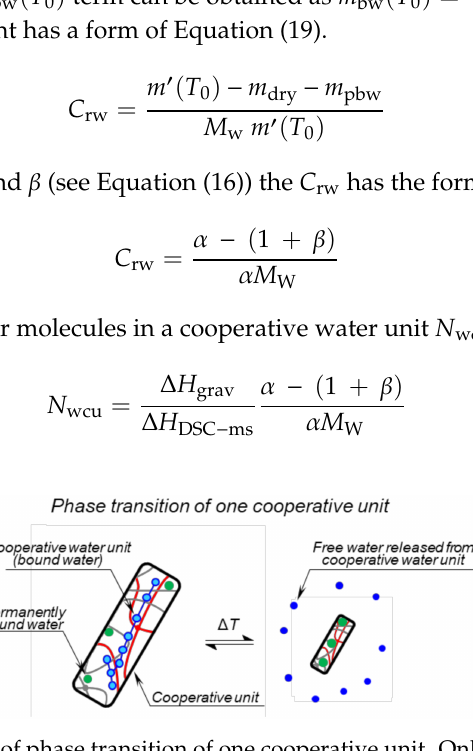
Figure 3. Schematic model of phase transition of one cooperative unit. Only one cooperative unit of the network sample is shown. Blue lines highlight the enhanced interaction between molecules of the cooperative water unit (containing N wcu